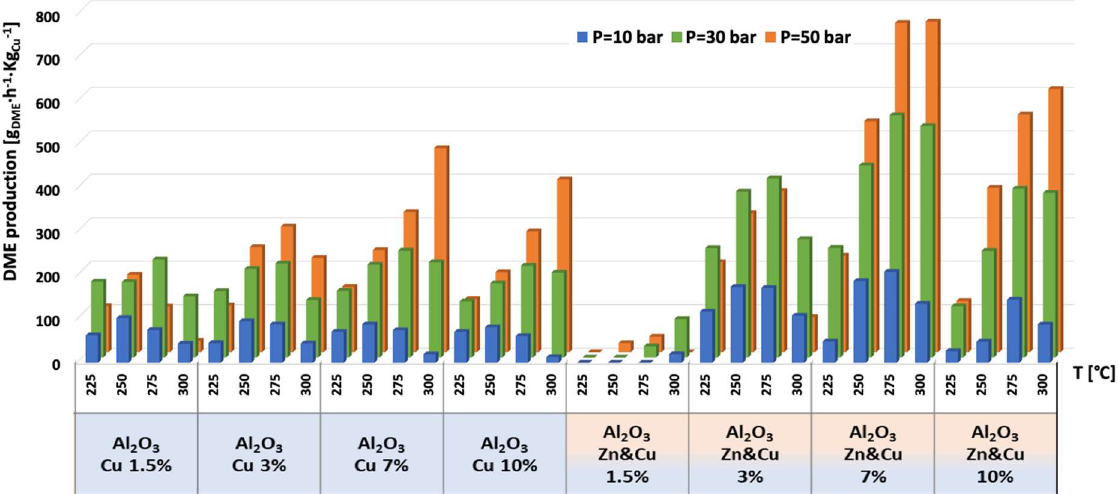
Figure 9. Production of methanol per gram of Cu for AlNFs-Cu and AlNFs-1Cu2.3Zn catalysts at pressures of 10, 30, and 50 bar and temperatures of 225, 250, 275, and 300 °C.